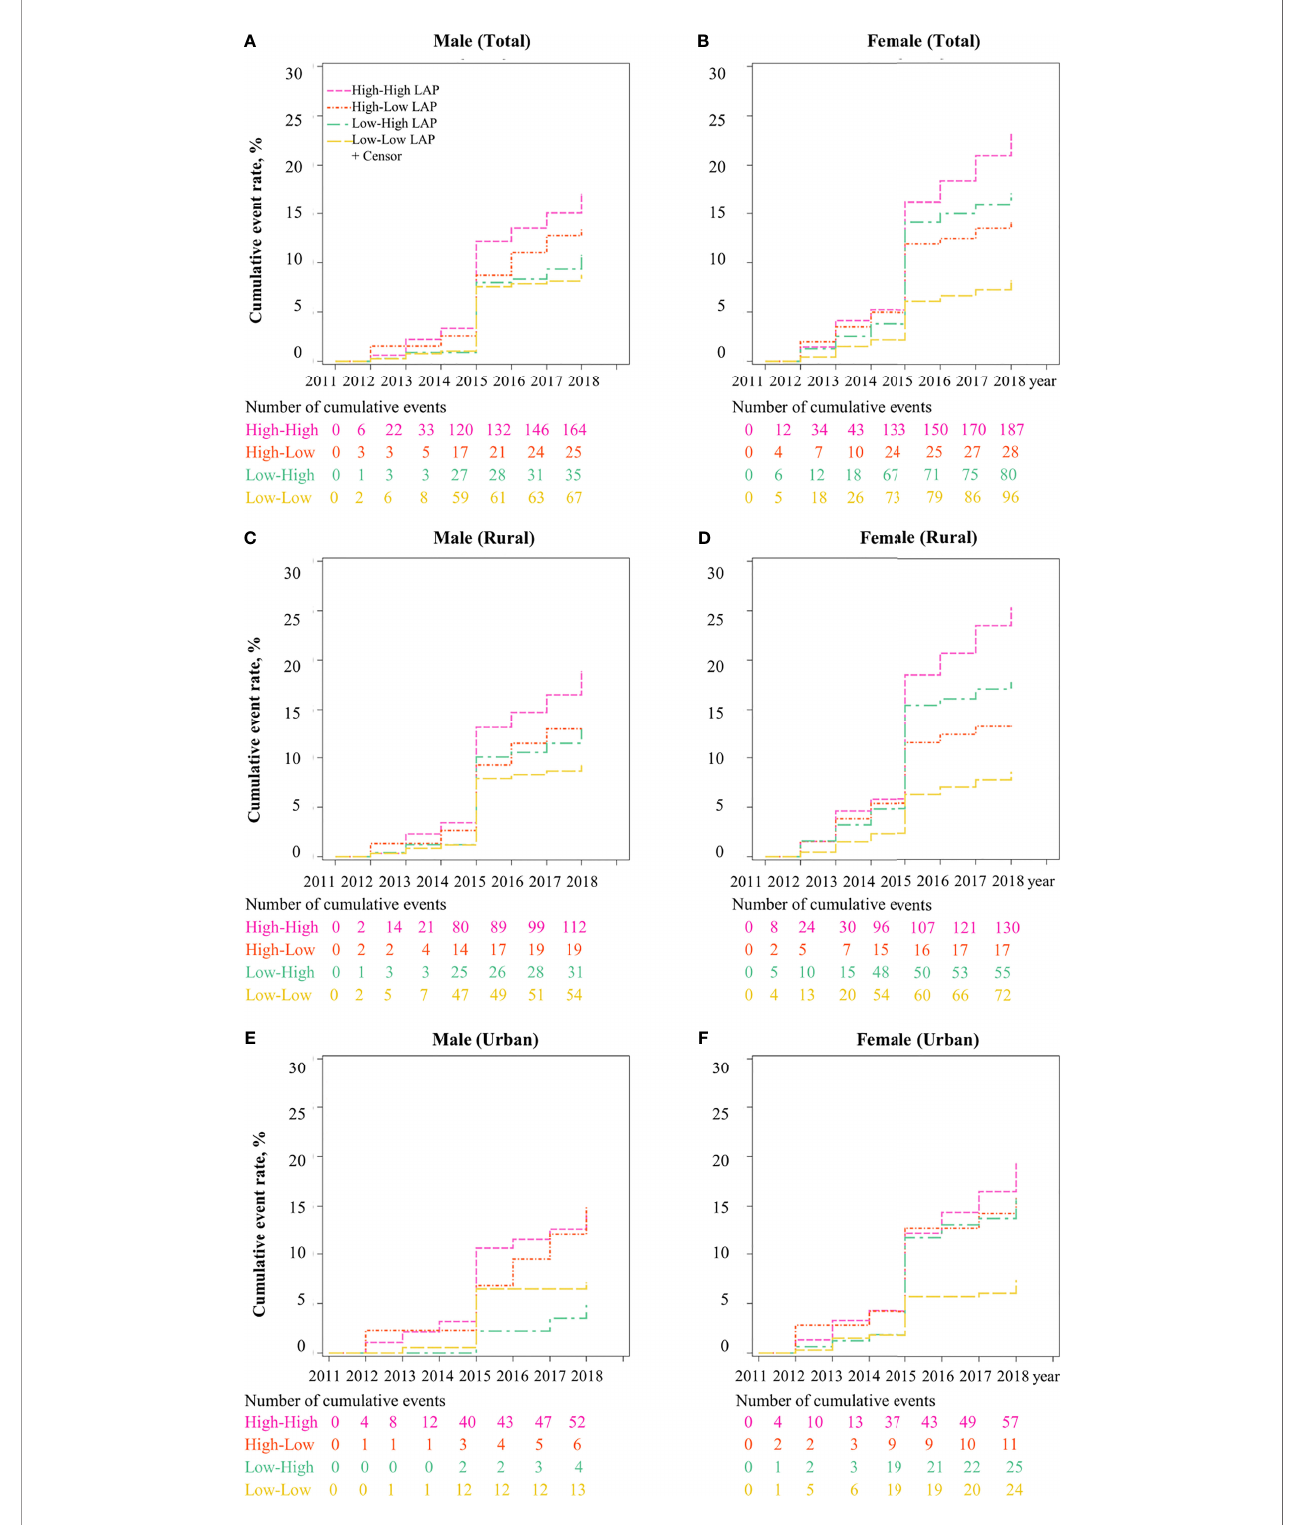
FIGURE 2 | Cumulative incidence of T2DM for LAP transitions from CHARLS 2011 to 2018. Note: LAP, lipid accumulation product; The cumulative event rate of T2DM was signi fi cantly different across four LAP transitions (high to high-, high to low-, low to high-, low to low-) in (A) Male, (B) Female, (C) Male in rural, (D) Female in rural, (E) Male in urban, and (F) Female in